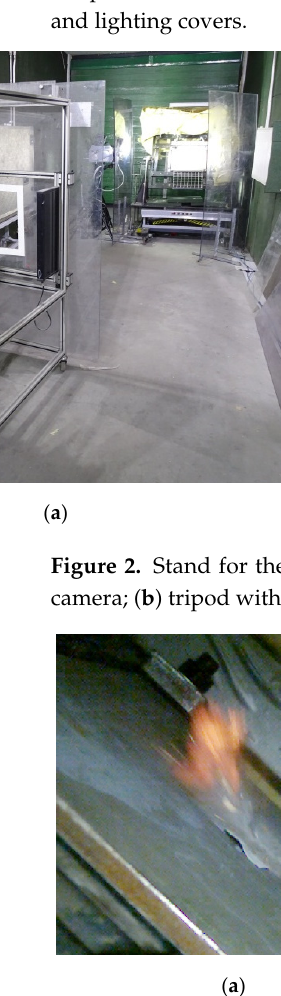
( b ) Figure 4. Recording of a 7.62 × 51 mm SWISS PAP projectile fired from a 7.62 × 51 mm ballistic barrel: ( a ) X6580sc camera (220 fps); ( b ) A6901scSLS camera (1000 fps). ( a ) ( b ) Figure 5. Registration of a 7.62 × 51T projectile fired from a 7.62 × 51 mm ballistic barrel: ( a ) X6580sc camera (220 fps); ( b ) A6901scSLS camera (1000 fps). 2.2. Projectile Ricochetting on Non ‐ Metallic Surfaces Projectile ricochetting tests on non ‐ metallic components were performed on an open range. A rack on which the projectile ricochetting plates were placed; an anti ‐ ricochet shield preventing the shrapnel from retreating to the shooting stand, a Photron Fastcam SA ‐ Z 2100K high ‐ speed camera (observation of projectile impact), FLIR X6580sc and FLIR A6901scSLS thermal cameras (measuring the temperature of the phenomenon) and a 7.62 × 54R calibre ballistic barrel were used for the tests (Figure 6).